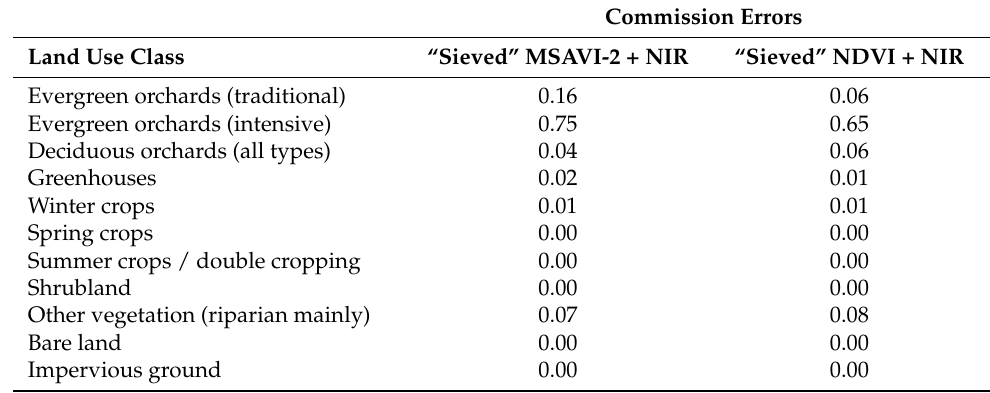
Commission Errors